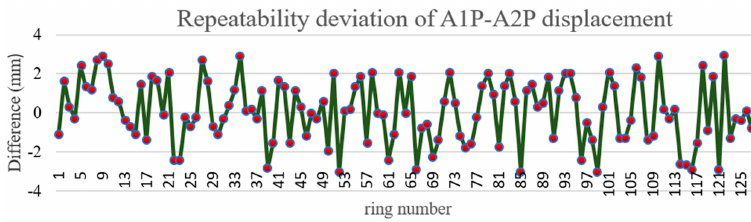
Figure 12. Repeatability deviation of A1P–A2P displacement.